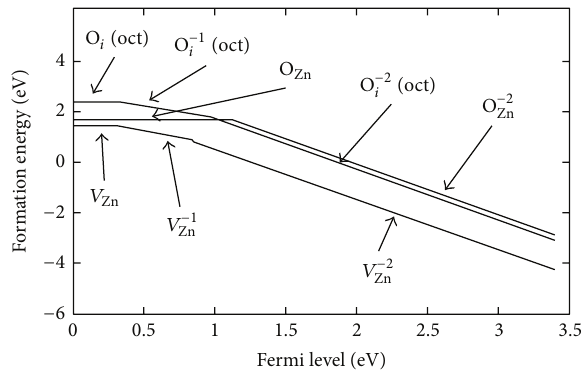
Figure 2: Calculated defect formation energy for selected defects as a function of the Fermi level and for 𝜇 zinc partial pressure). Only the lowest formation energy values are shown. The zero of the Fermi level is set to the top of the valence band. Reprinted with permission from [13]. Copyright 2000 by the American Physical Society.